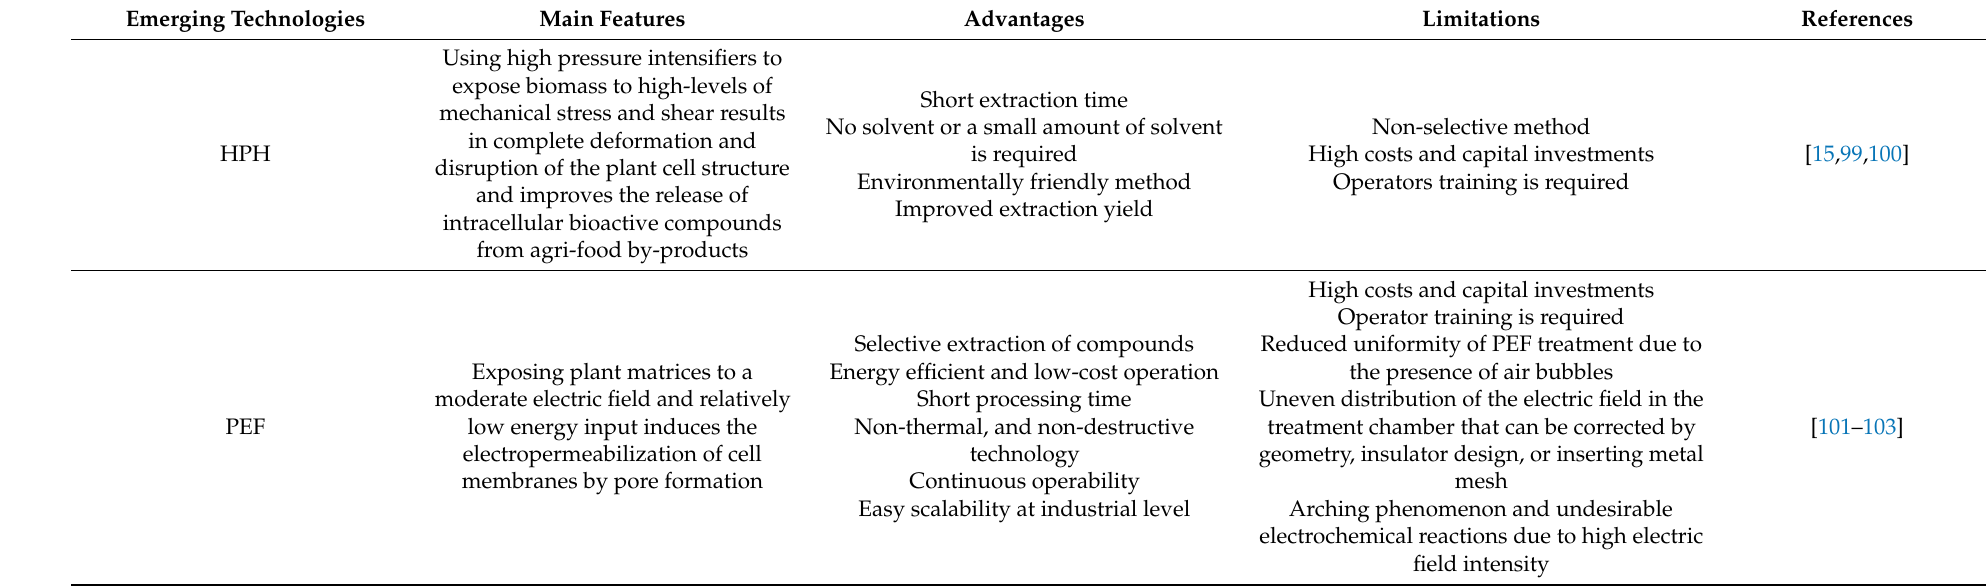
Table 4. Main features, advantages, and limitations of emerging extraction